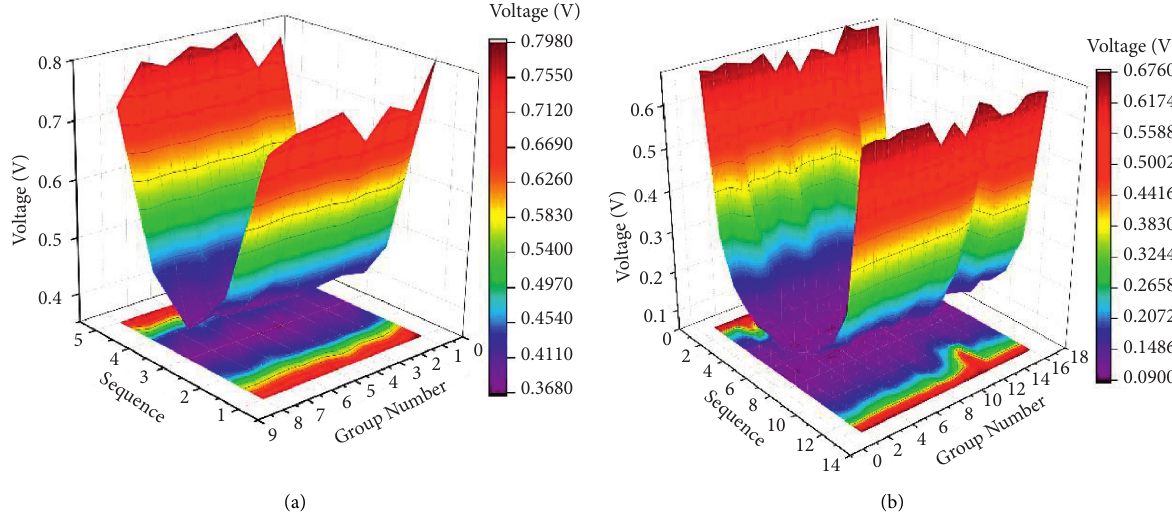
Figure 12: Measurement data graph. (a) A plot of 8-electrode perforated disc measurement data; (b) a story of 16-electrode perforated disc measurement